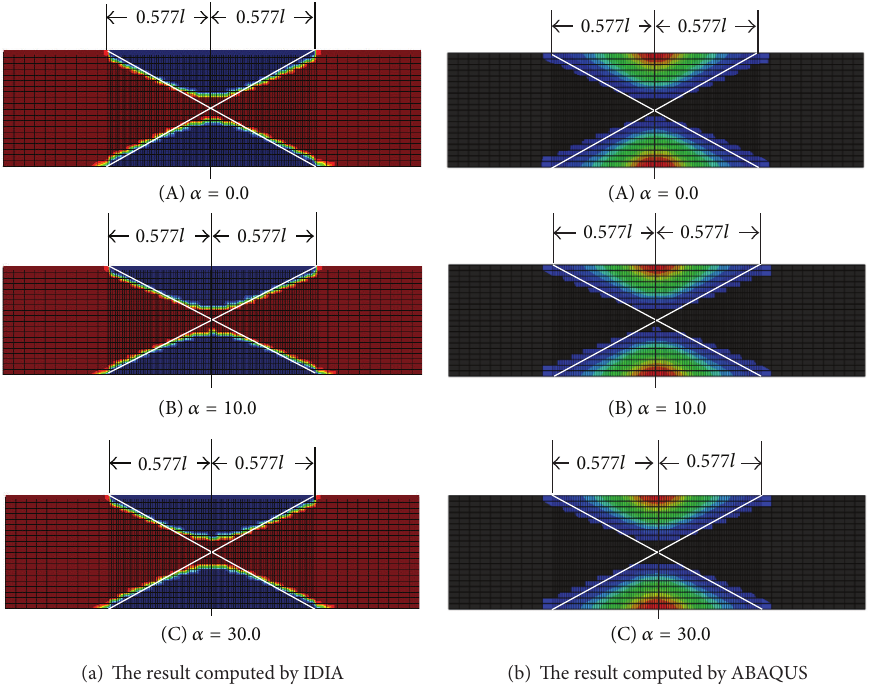
Figure 8: Plastic area under dynamical load ( 𝑀 𝑝 = 1.5𝑀 𝑒 ), respectively, by IDIA and